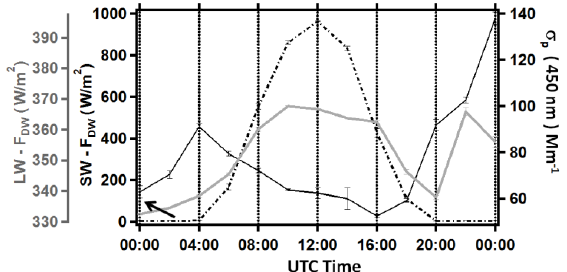
Figure 10. Daily evolution of the two hour-averaged values of σ p (black solid line), SW-F DW (black dotted line), and LW-F DW (grey solid line) on 8 May 2015. The error bars represent the corresponding SEMs.